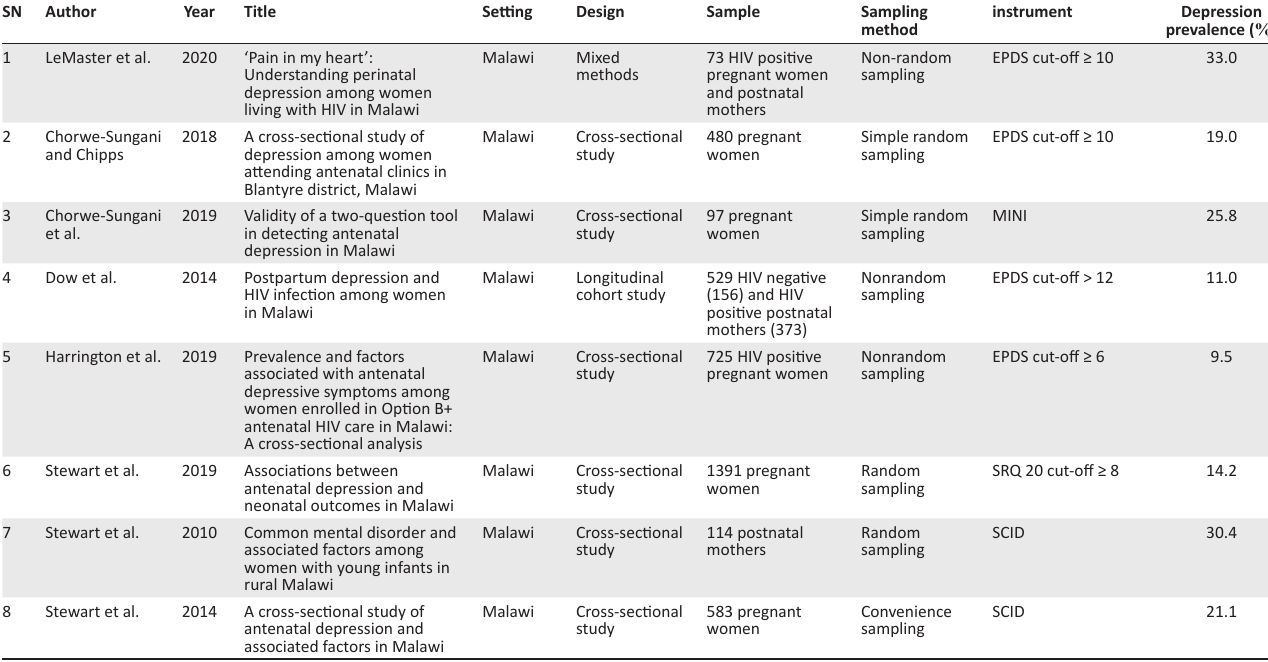
TABLE 3: Results for included studies ( n = 8).